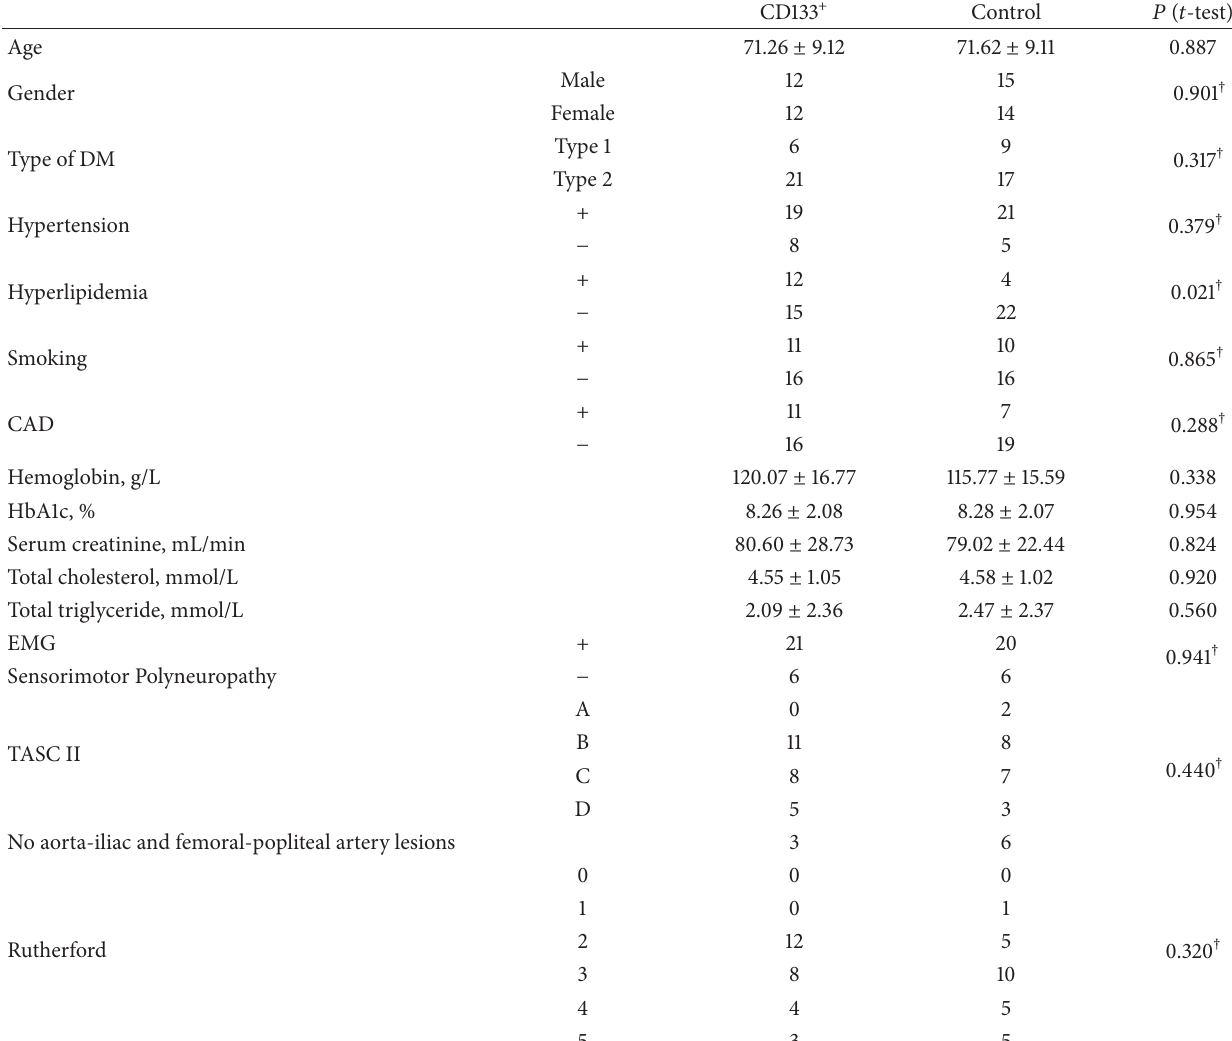
Table 1: Baseline characteristics of